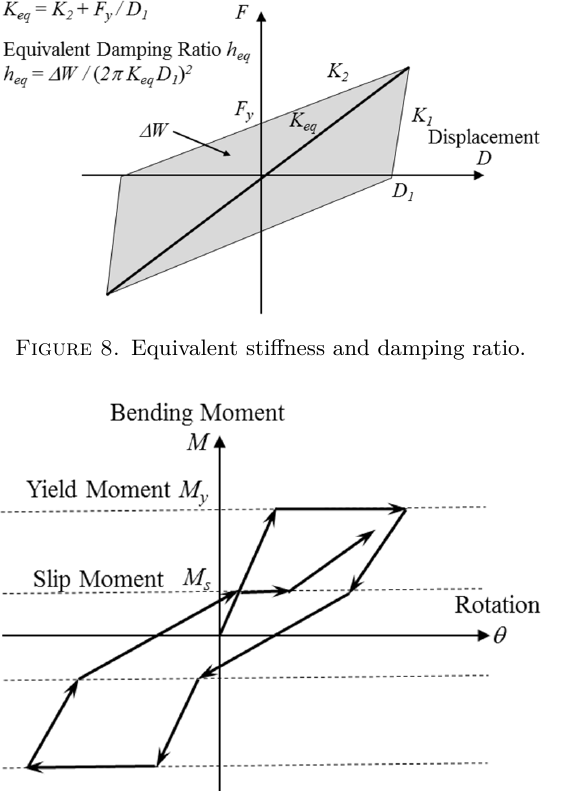
Figure 9. Nonlinear model for rotational spring